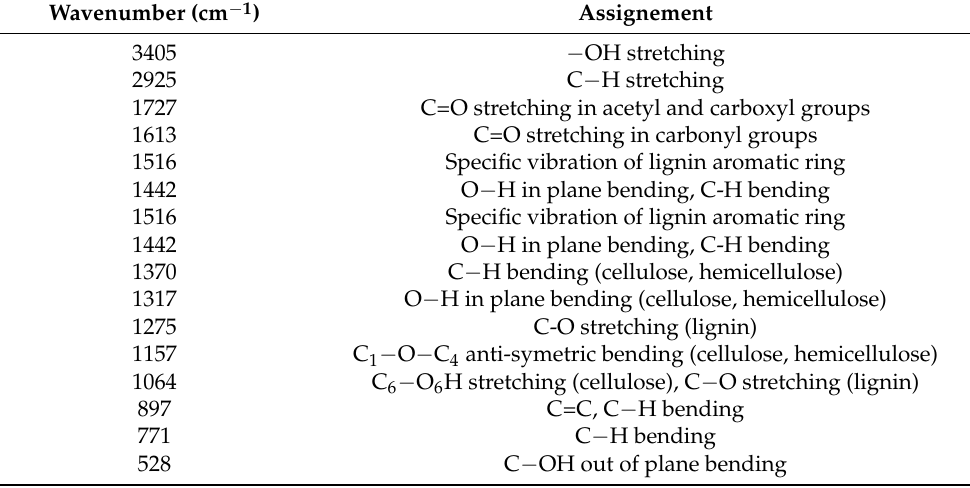
Table 2. Significant peak assignment for the ligno-cellulosic waste.